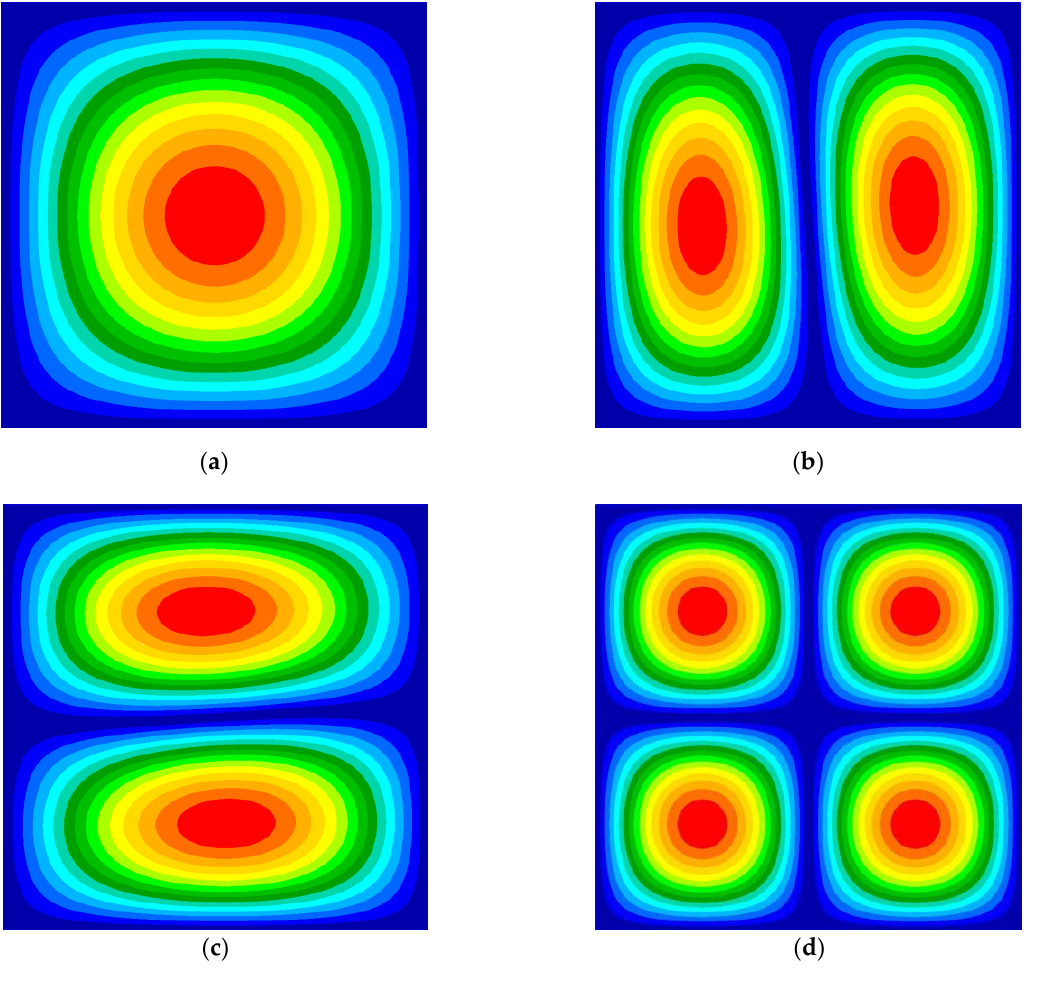
Figure 14. The first 4 modes of the panel with no mass attachment: ( a ) the 1st mode (64.55 Hz); ( b ) the 2nd mode (161.4 Hz); ( c ) the 3rd mode (161.4 Hz); ( d ) the 4th mode (258.1 Hz).